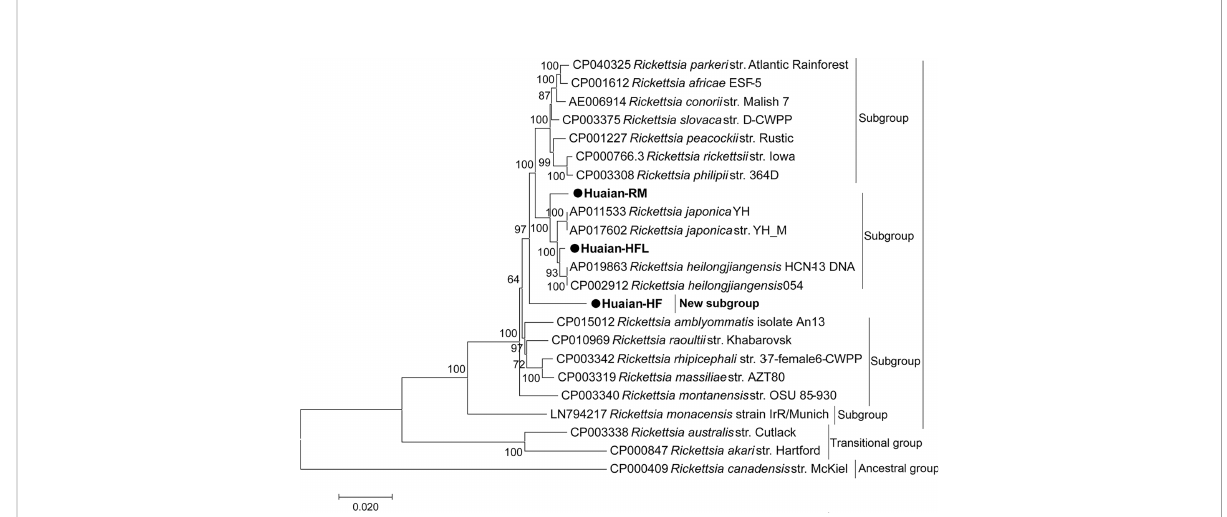
FIGURE 3 Phylogenetic tree of Rickettsia spp. based on a concatenated sequence of gltA , rrs , ompA , ompB , and sca4 gene sequences. The phylogenetic tree was generated with MEGA 7.0 software using the maximum likelihood method with 1,000 replicates for bootstrap testing. Bootstrap values > 50% are shown. The scale bar indicates nucleotide substitutions per site. The GenBank accession numbers of the reference sequences are indicated. The newly obtained sequences are indicated with black dots.